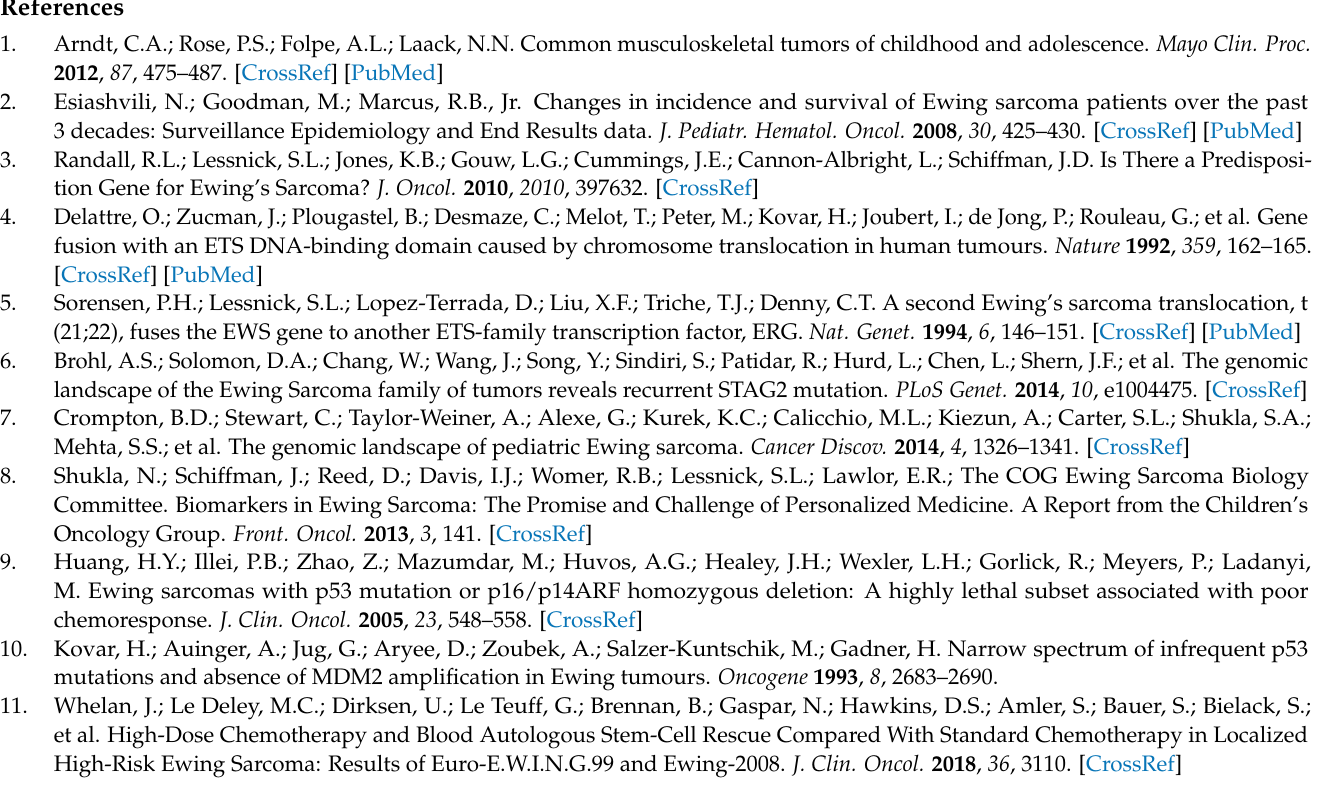
Table S2. The top 15 REACTOME pathways of DERBPs in ES. Table S3. The top 15 hub genes with the highest degree of connectivity in the PPI network. Table S4. Correlations between RBPs and TFs. Table S5. ssGSEA scores of 50 Hallmarks and risk score in training cohort. Table S6. The correlations between risk score and 23 significant hallmarks. Table S7. IHC scoring and corresponding clinical characteristics in 24 Ewing sarcoma patients’